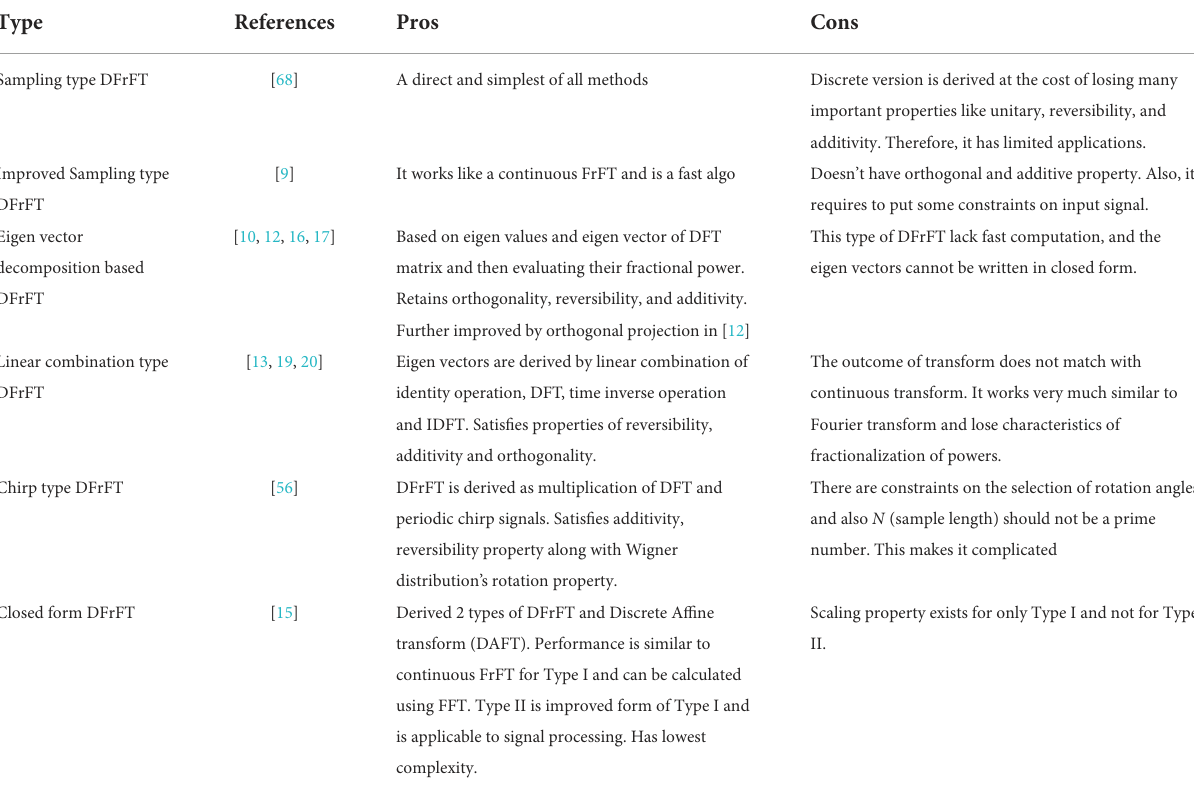
TABLE 5 Various methods for discretization of Linear Canonical